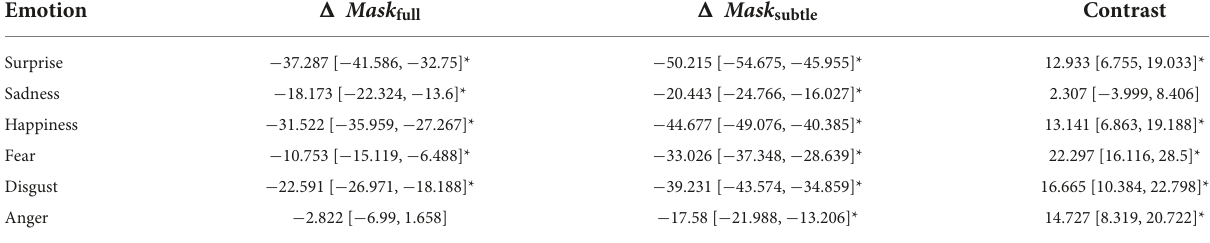
TABLE 4 Posterior distribution summaries for the perceived intensity Mask effect as a function of the displayed